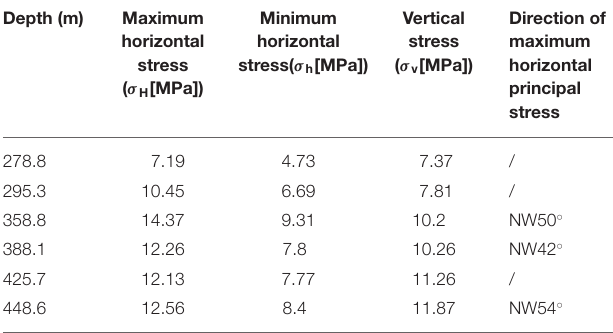
TABLE 1 | Geo-stress test in the large deformation section at Gaopo